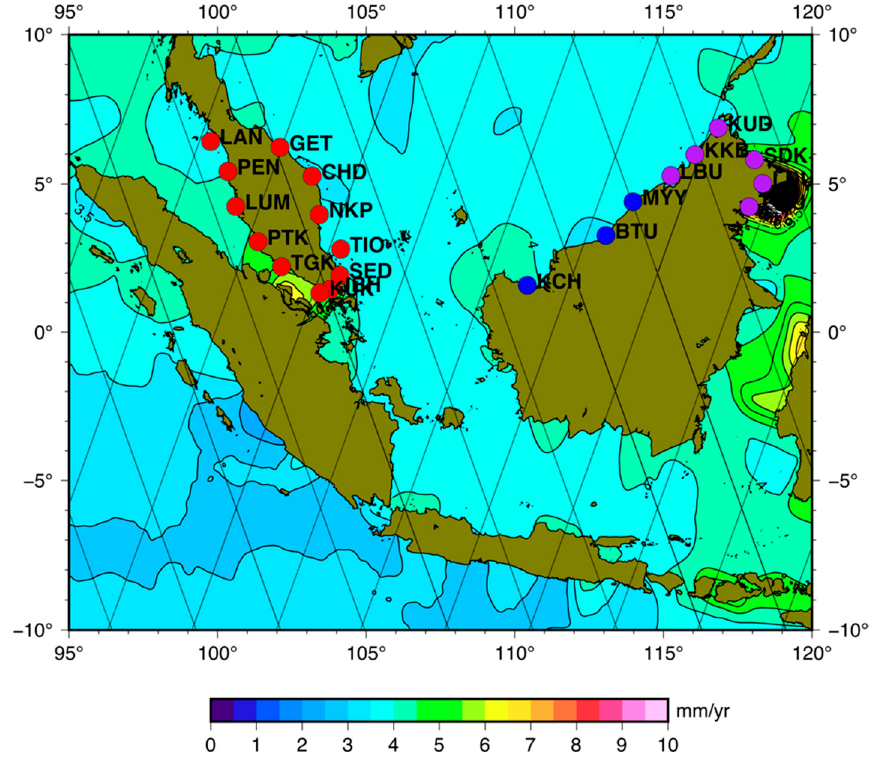
Figure 4. The Malaysian study area with the tide-gauge locations and, superimposed, the satellite tracks of the reference missions such as TOPEX and the Jasons. Again, in the background, we see the geographical distribution of the trend of the absolute sea level w.r.t the mean surface model (sea level anomaly SLA). The y -axis is the latitude (N) and the x -axis is the longitude (E), both given in